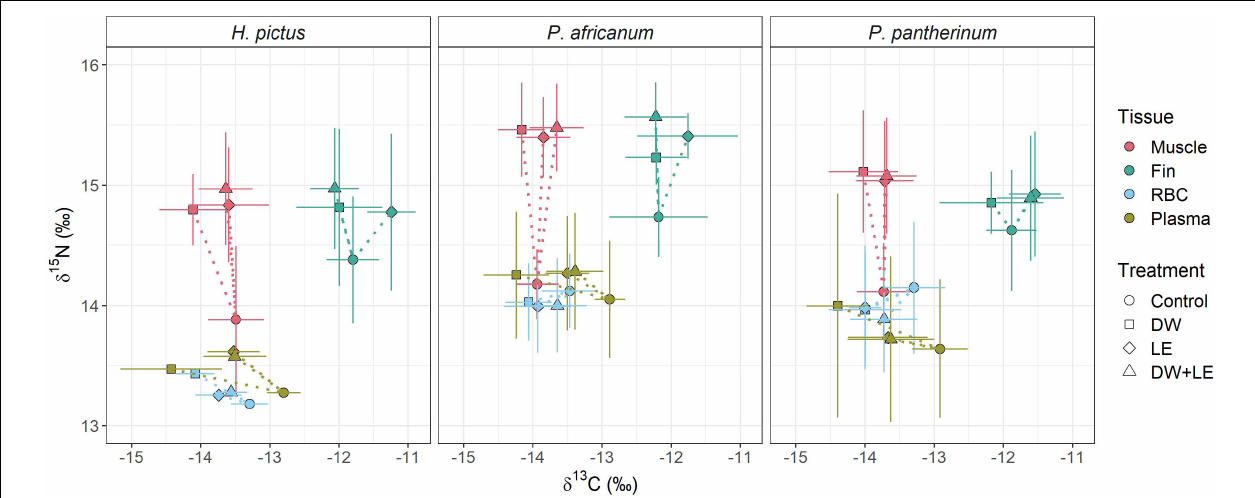
FIGURE 1 | Mean ( ± standard deviation) δ 13 C and δ 15 N bulk isotope values of three different shark tissues and components sampled from three species and subjected to four different treatments. RBC, red blood cells; Control, no treatment; DW, deionized water rinse; LF, lipid extraction; DW+LE, water rinse followed by lipid extraction. Dotted lines indicate shifts in mean isotope values relative to the